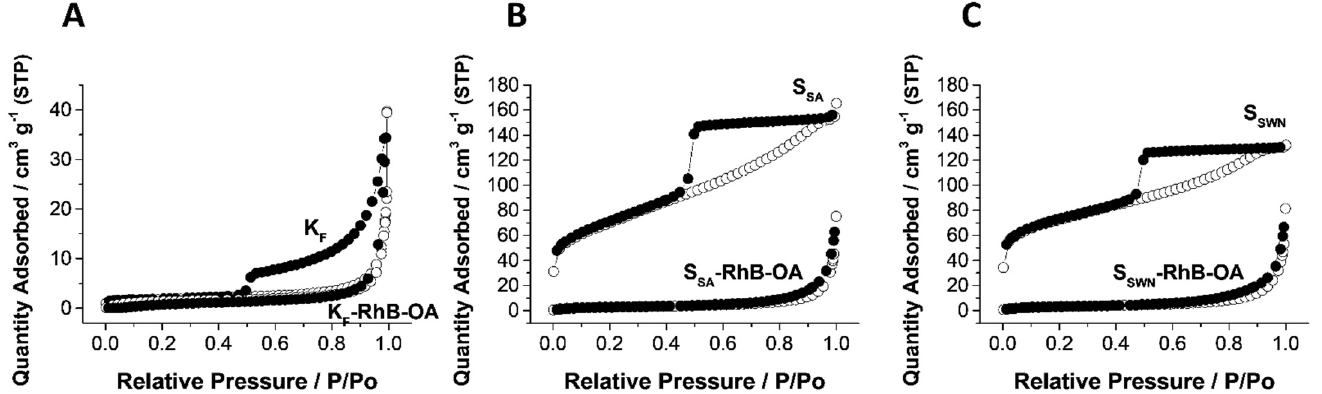
Figure 3. Nitrogen adsorption ( ○ )—desorption ( ● ) isotherms for all of the bare clays and final model gated organonanoclays. ( A ), K F and K F -RhB-OA; ( B ), S SA and S SA -RhB-OA; ( C ), S SWN and S SWN -RhB- OA. Table 2. BET specific surface values and pore volumes calculated from the N 2 adsorption-desorption isotherms for selected materials.